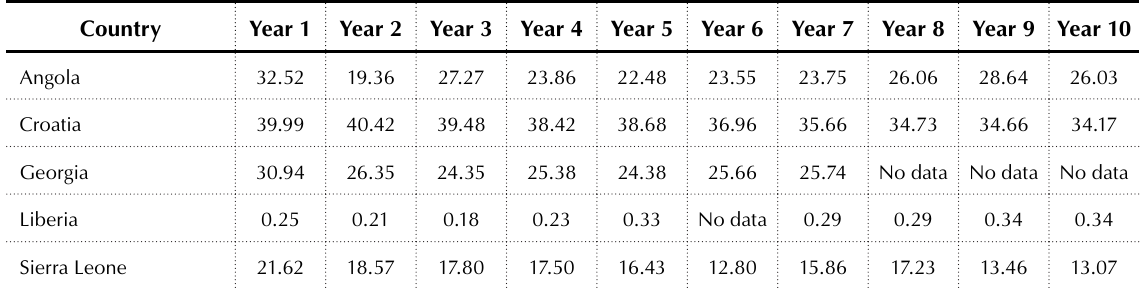
Table 8. Government expense, % of